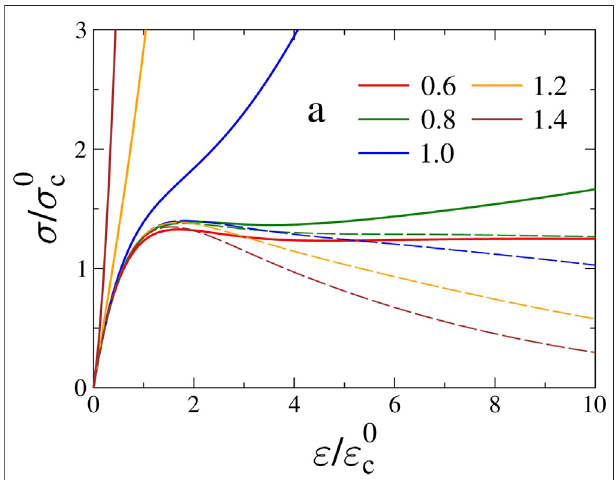
FIGURE 2| Constitutivebehavior ofthe stick-slip bundle with quenched disorder of the sliding thresholds according to Eq. 8 including both cases of remaining stiffness (continuous lines) and ultimate failure of fi bers (dashed lines) after completing K slip events. The arrows highlight unloading curves, which start at different strains ε m of the constitutive curve of the softening bundle of K (cid:1) 5. The value of the stiffness parameter is a (cid:1) 0 . 8.